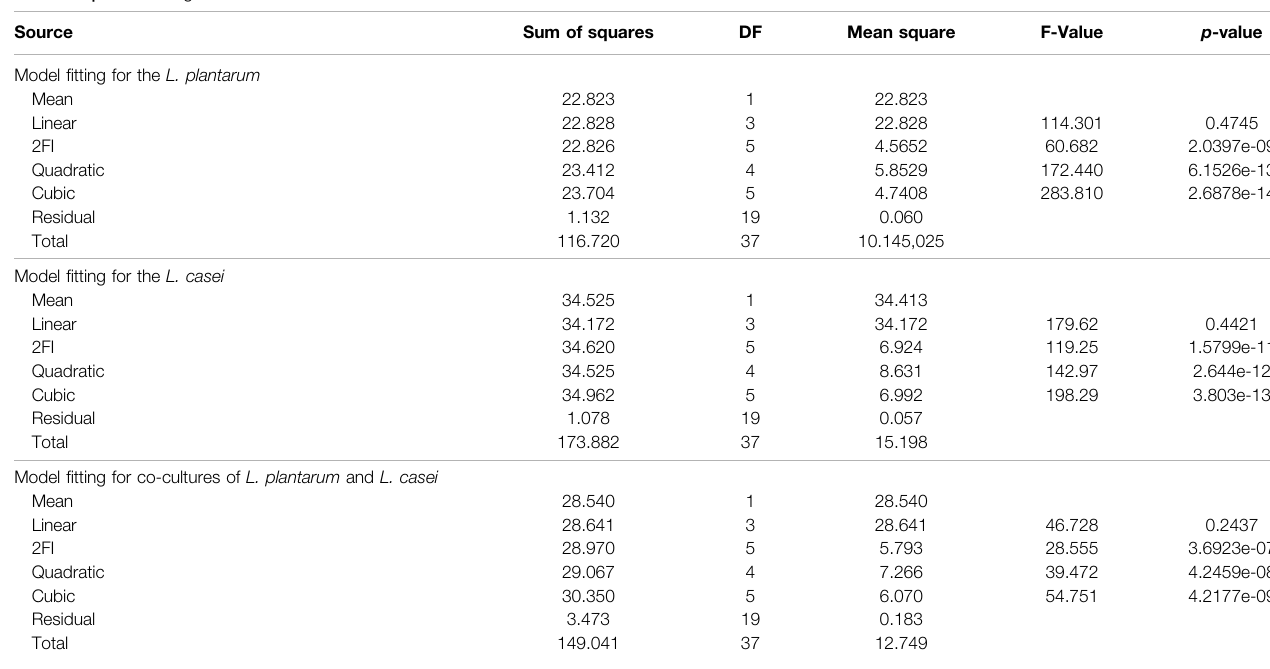
TABLE 1 | Model fi